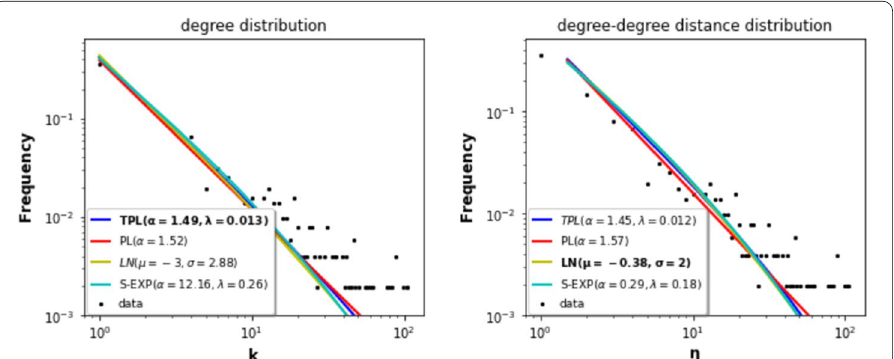
Fig. 13 The degree (left) and degree-degree distance (right) distributions of the large global component. Empirical distribution (dot), estimates (line).The distribution under test are: power law (PL), truncated power law (TPL), log-normal (LN) and stretched exponential (S-EXP). The values in bold are the parameters of the best fit according to the Kolmogorov-Smirnov